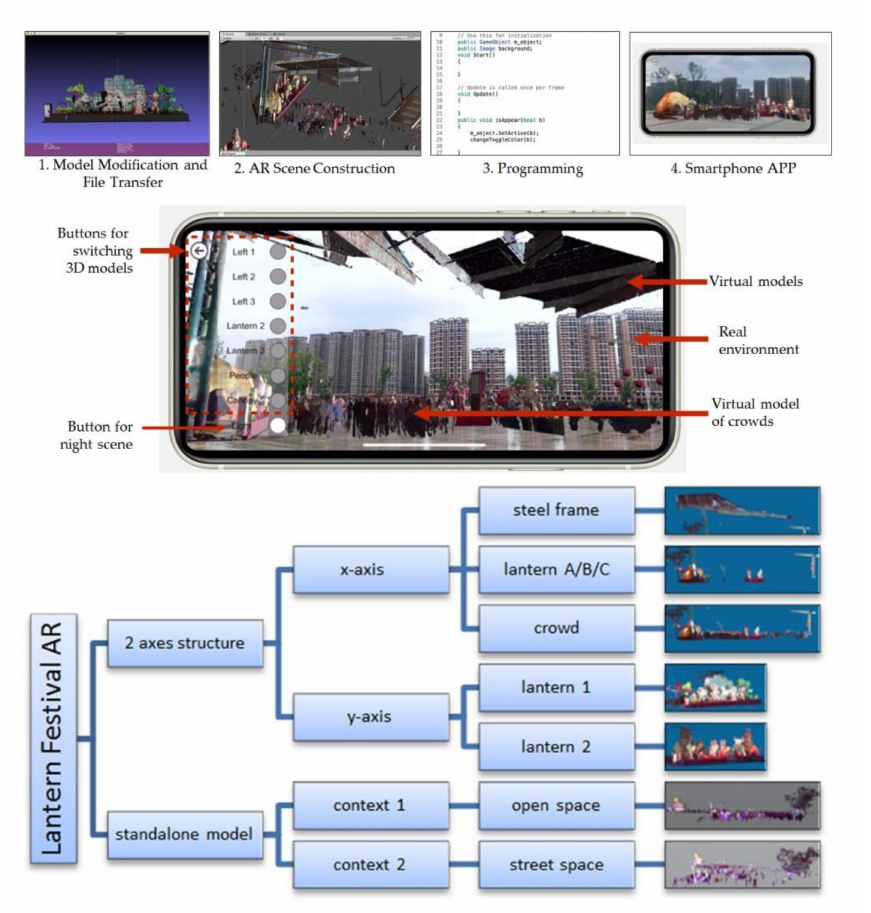
Figure 9. The development process of the AR APP ( top ), smartphone interface ( middle ), and the structural entities of the lantern festival ( bottom